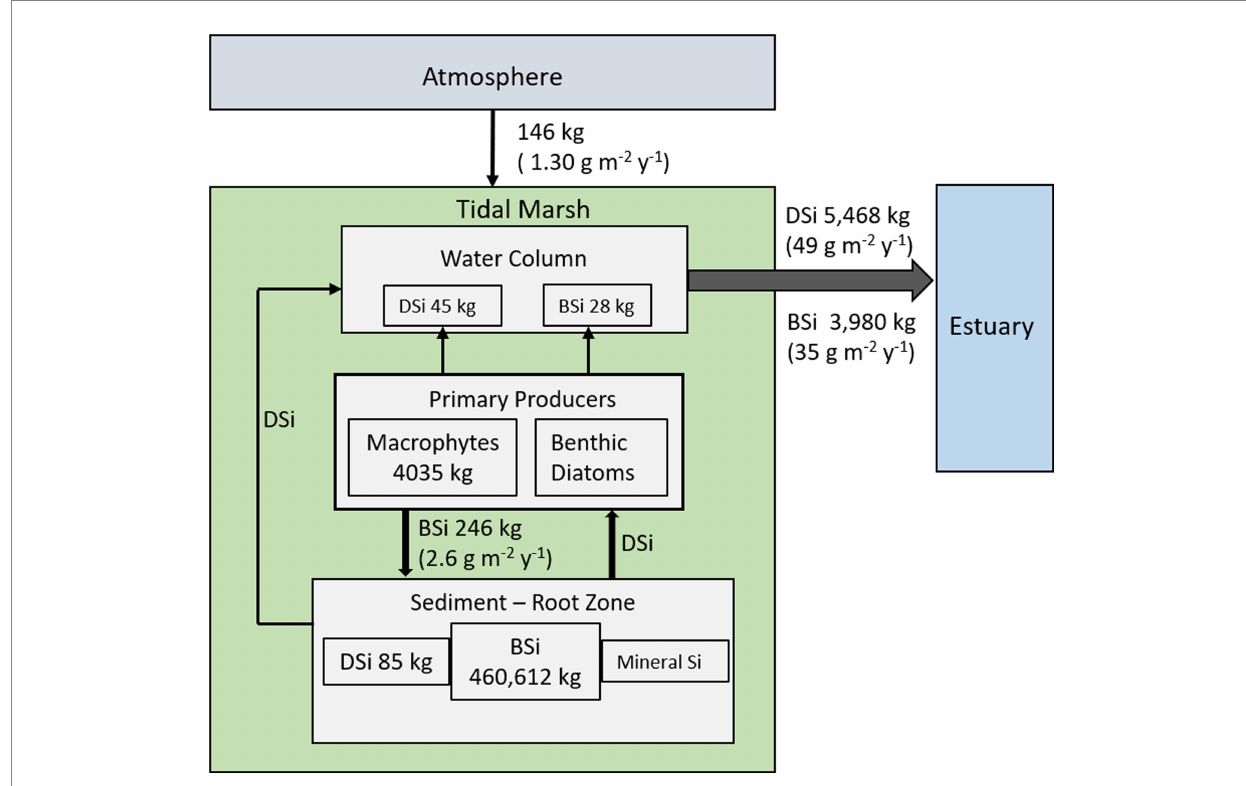
FIGURE 6 Conceptual model of annual SiO 2 mass balance for the Cell 1B tidal marsh at Poplar Island. All fluxes for the marsh are expressed as SiO 2 (annual, kg SiO